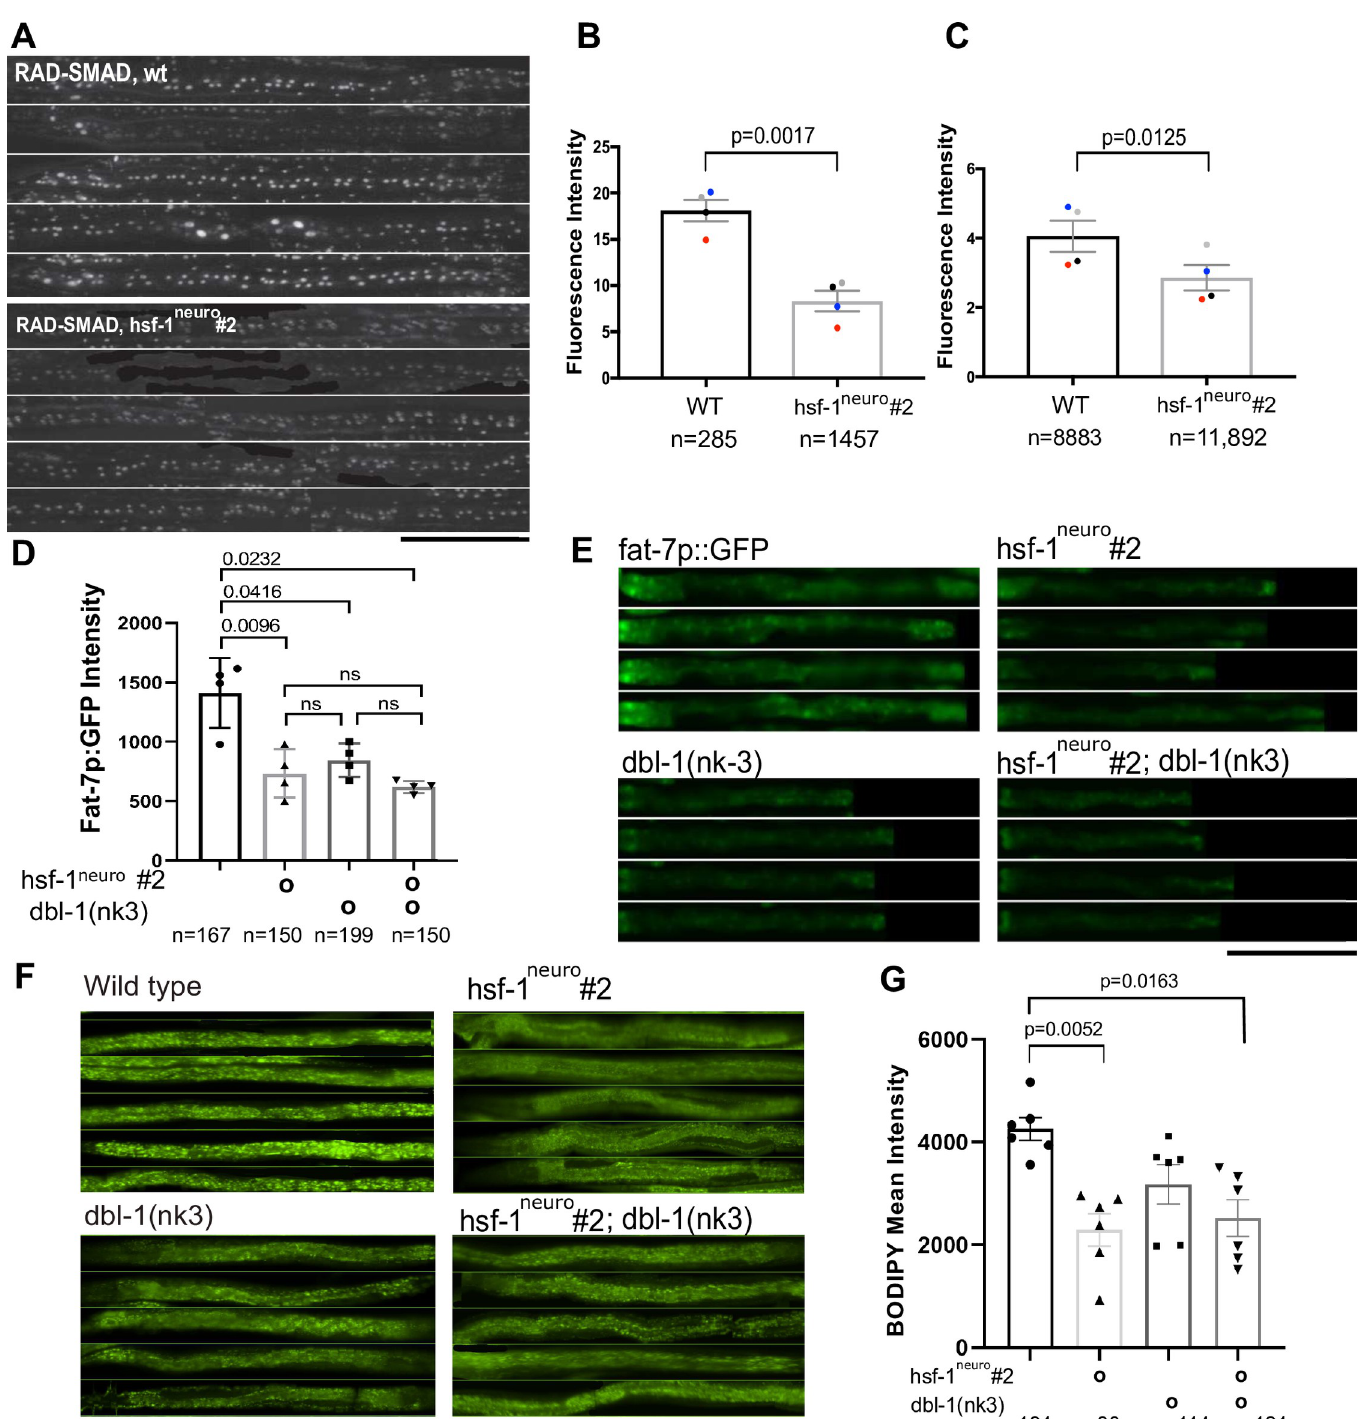
Fig 4. Neuronal stress remodels fat metabolism by suppressing TGF- β /BMP signaling. (A–C) Neuronal stress decreases the fluorescent GFP output of an in vivo RAD-SMAD reporter that directly and positively responds to TGF- β /BMP signaling [48]. (A) At 20˚C, there is a reduction in nuclear GFP signal of L4.8-stage, hsf-1 neuro #2 animals (MOC229, lower panel) compared to age-matched controls (LW2436, upper panel). (B) Quantification of fluorescence levels of RAD-SMAD reporter in large intestinal nuclei ( > 60 um) (C) and in small hypodermal nuclei ( < 60 um). Paired t test shows a significant difference in the mean fluorescence levels of controls relative to hsf-1 neuro #2 animals ( S6 Table ). N values correspond to the number of fluorescent nuclei across all worms from 4 independent replicates (total number of worms: 131 in WT and 115 in hsf-1 neuro ) . Paired replicates have been color coded to show consistency. (D, E) Genetic epistasis shows that hsf-1 neuro and dbl-1 work in a linear pathway to